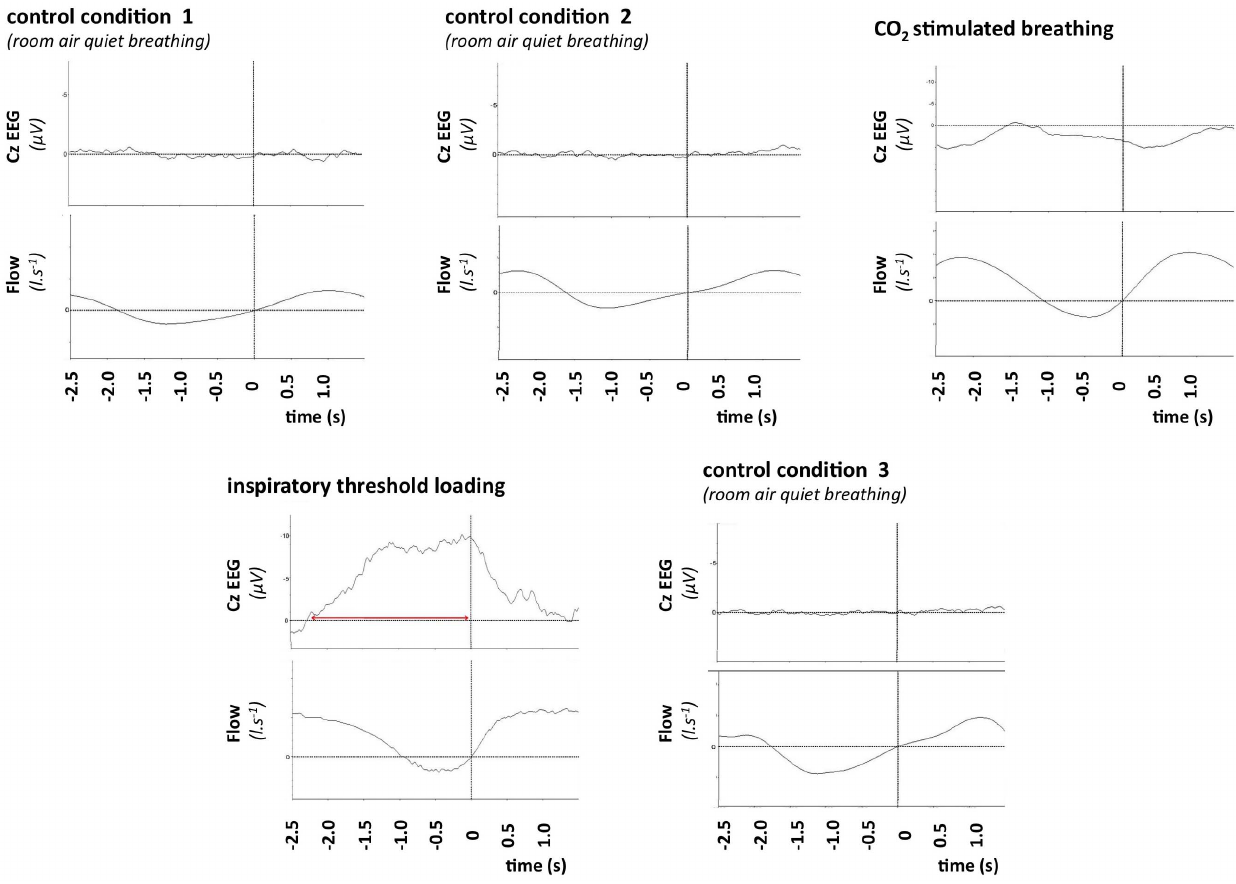
Figure 2. Average pre-inspiratory EEG tracings in one of the control subjects. In each of the panels, the top trace depicts the Cz-EEG signal, and the bottom trace depicts ventilatory flow. The vertical line indicates the onset of inspiration. In the three ‘‘control condition’’ panels (control 1: resting ventilation with minimal constraint, namely a respiratory inductance plethysmography vest only; control 2: resting ventilation while breathing through a pneumoatchograph; control 3: as control 2, but during the washout period following inspiratory loading), inspiration is not preceded by any change in the EEG signal (absence of pre-inspiratory potentials). In the ‘‘CO 2 stimulated breathing’’ panel, inspiration is also not preceded by any change in the EEG signal (absence of pre-inspiratory potentials). In contrast, in the ‘‘inspiratory threshold loading’’ panel, inspiration is preceded by a shift upward of the EEG trace (horizontal double arrowed red line) that is characteristic of a pre-inspiratory potential. This pattern exactly corresponds to what is expected in normal individuals [12].